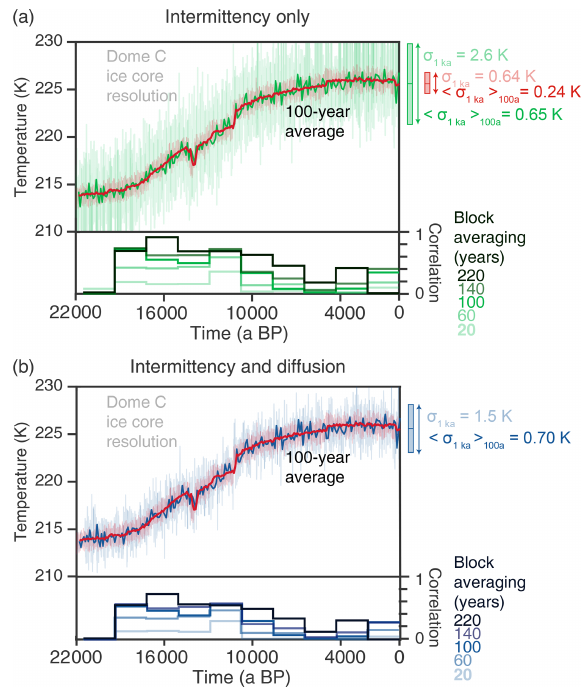
Figure 8. Application of the forward model to the temperature time series of the last deglaciation obtained from the Trace21k model simulation for Dome C. The pure climatic signal has been resam- pled at a fixed temporal resolution of 5.8 years to match the sam- pling rate of the top of the ice core (light red) and of 100 years (dark red). (a) Intermittent virtual core (light green: ice core resolution; dark green: 100-year averages) and running correlation between the intermittent virtual core and the climatic signal for different block- averaging windows. (b) Intermittent and diffused virtual core (light blue: ice core resolution; dark blue: 100-year averages) and running correlation between the intermittent and diffused virtual core and the climatic signal for different block-averaging windows.